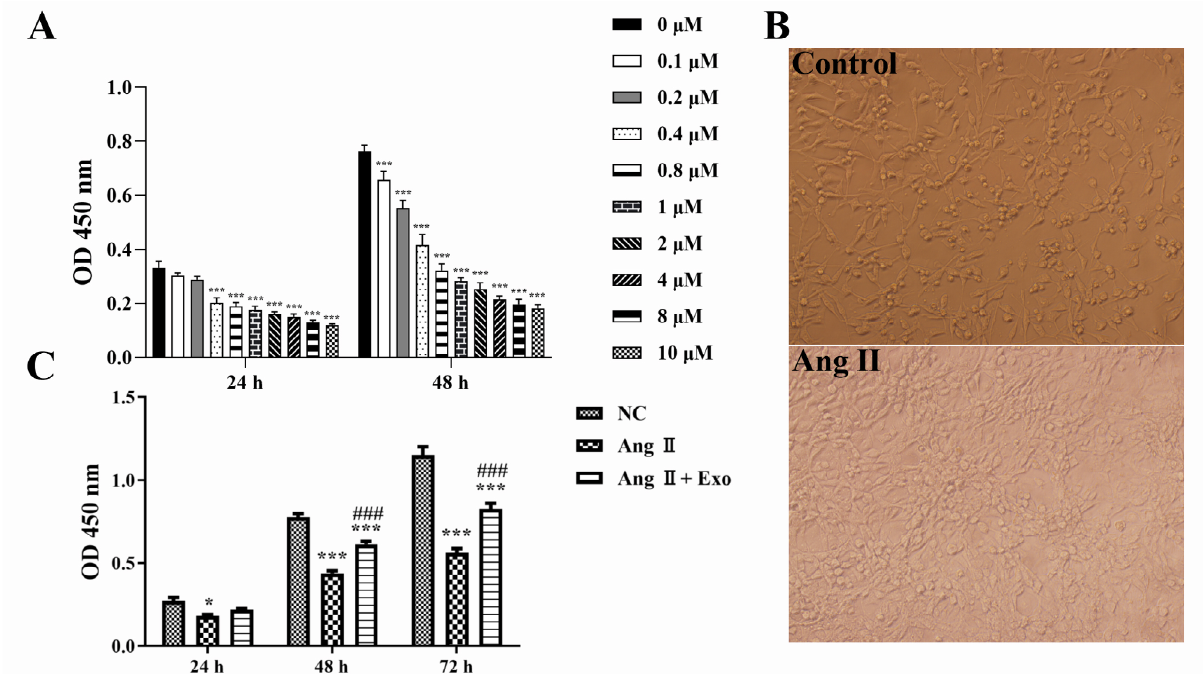
Figure 2 – The effect of MSCs-exosomes on cardiomyocytes. A. The viability of H9c2 cells was examined by Cell Counting Kit (CCK)-8 assay. H9c2 cells were treated with different concentrations of angiotensin II (Ang II; 0-10 μM) for 24 and 48 h. B. Morphology of H9c2 cells treated with Ang II (0.4 μM). C. The proliferation of H9c2 cells was examined by CCK-8 assay. H9c2 cells were treated with Ang II (0.4 μM) or/and MSCs-exosomes. * P < 0.05 and *** P < 0.001 vs. the NC (negative control) group; ### P < 0.001 vs. the Ang II